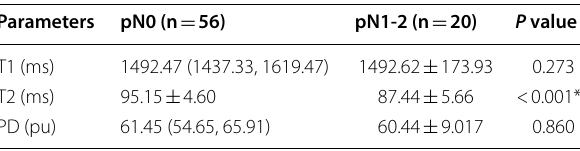
Table 5 Differences of quantitative parameters between the pN0 and pN1‑2 groups